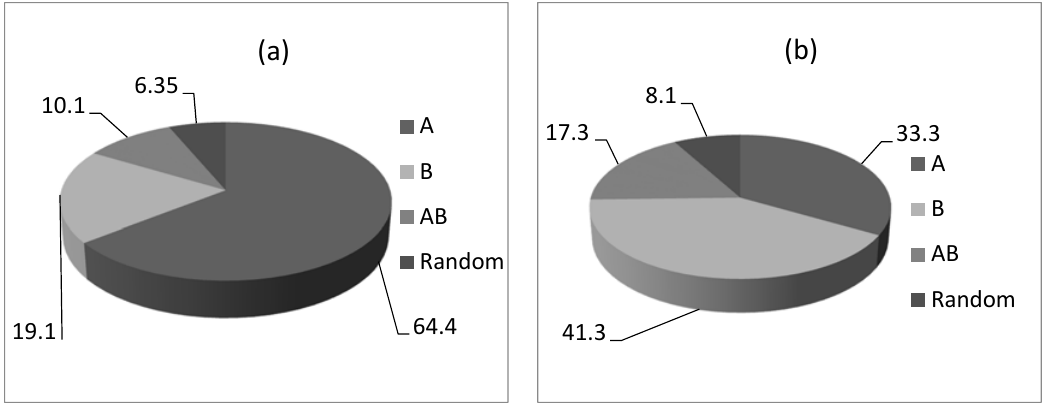
Figure 1. R of two-way ANOVA of 11 lines of pearl millet Pennisetum glaucum : ( a ) green biomass (%), ( b ) grainyields (%), where A—Genotype, B—Salinity level, AB—Genotype–salinity level. Table 2. Results of two-way ANOVA on effect of salinity level and genotype on green biomass and grain yields of 11 lines of pearl millet Pennisetum glaucum. F—Fisher distribution, df—degree of